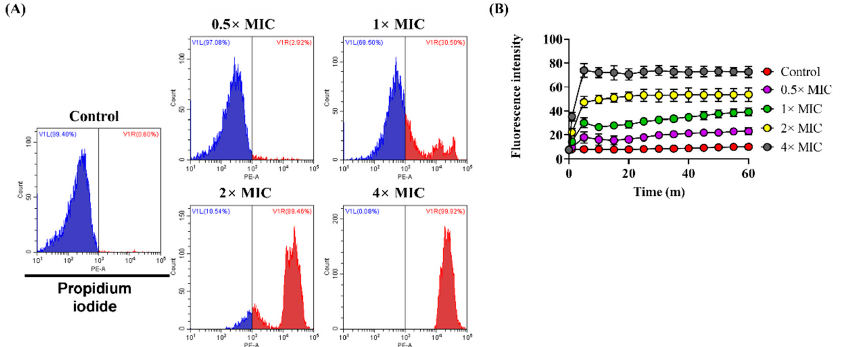
Figure 3. Analysis of Candida albicans membrane integrity after incubation with Lycosin-II. Lycosin-II at 0.5×, 1×, 2×, and 4× MICs were incubated with C. albicans . ( A ) A flow cytometry analysis of membrane permeabilization using PI (10 μ g/mL) in C. albicans . ( B ) The kinetics of the membrane disruption of C. albicans were confirmed using SYTOX green (1 μ M), as well as by monitoring the fluorescence intensity. Abbreviations: PI, propidium iodide; MIC, minimum inhibitory concentration.